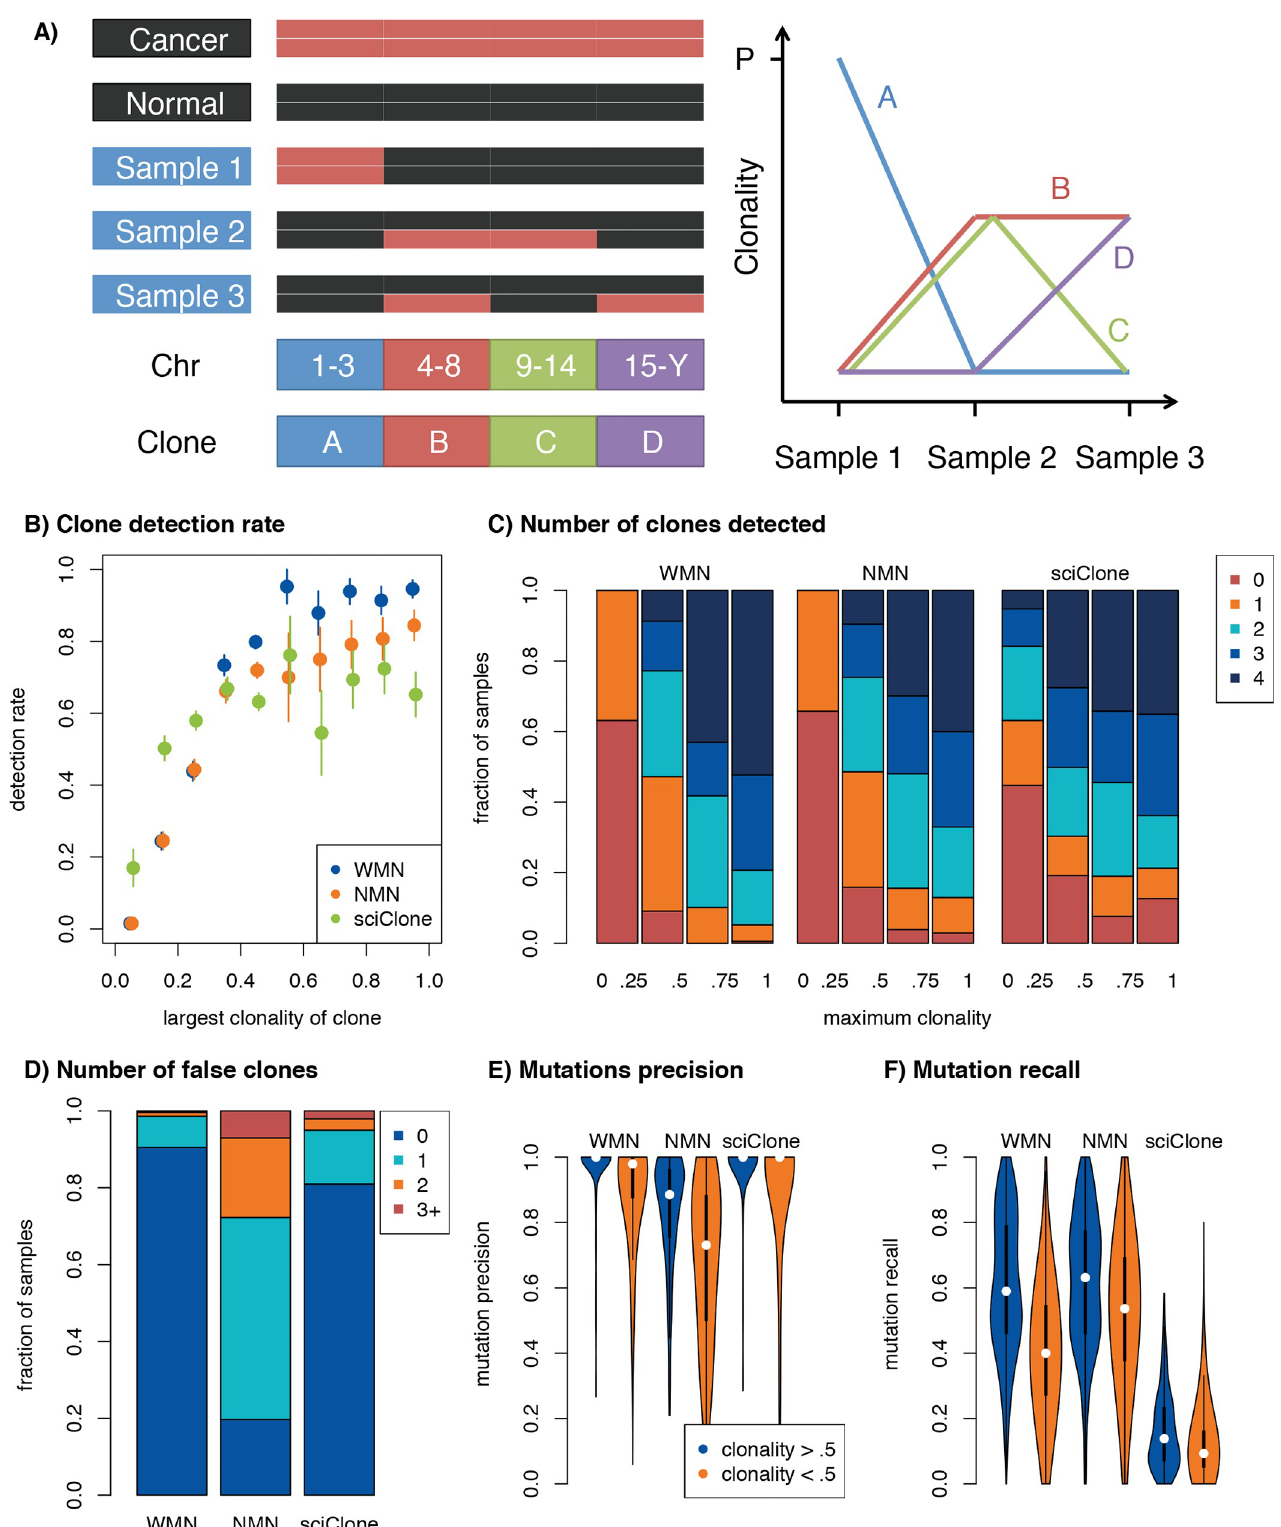
Fig 4. Precision and recall of SuperFreq clonal tracking. (A) Overview of simulations. As illustrated on the left, the genome is divided into four regions (chr 1–3, 4–8, 9–14 and 15-Y), and the cancer and normal samples are blended to create three samples that contain four clones supported by mutations that reside in